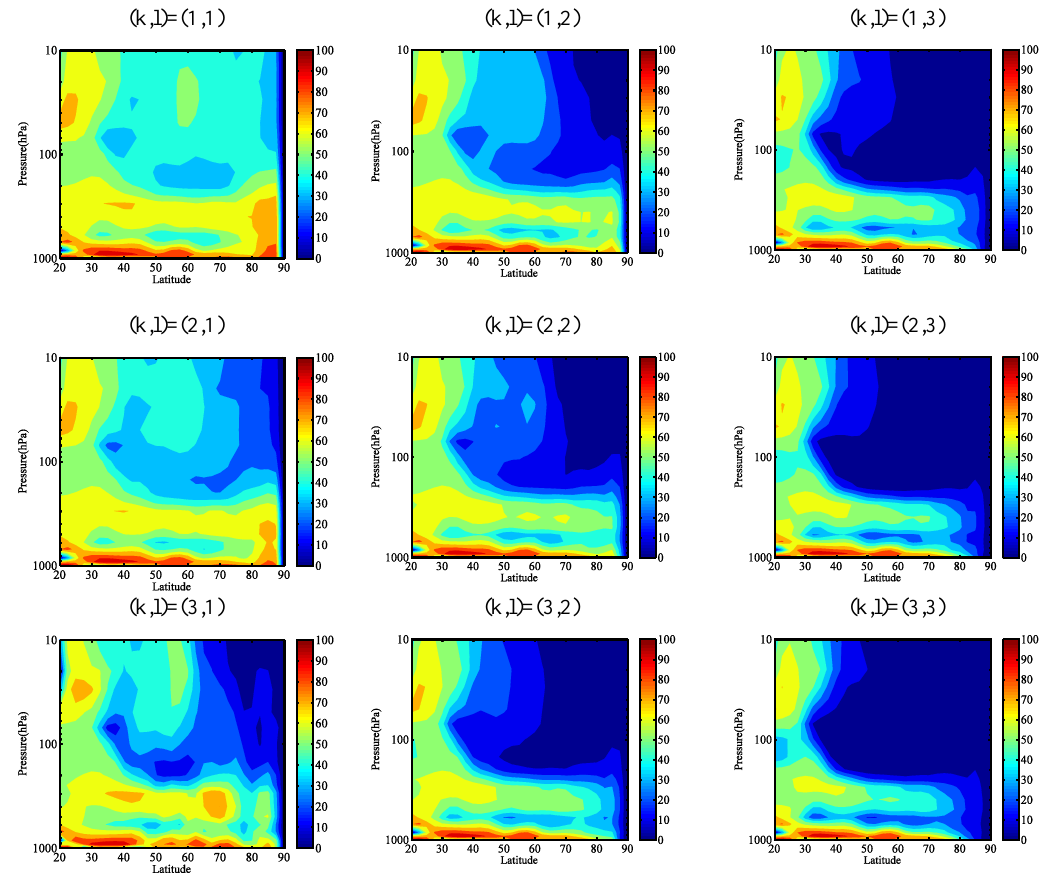
Figure 8. Probability of favorable propagation condition for Rossby waves derived from 50 winters (1961–2010) in the Northern Hemisphere. The higher the values, the more convenient it is for planetary waves to propagate to that region. In contrast, planetary waves are likely to be trapped in the vertical direction when the value of this quantity is